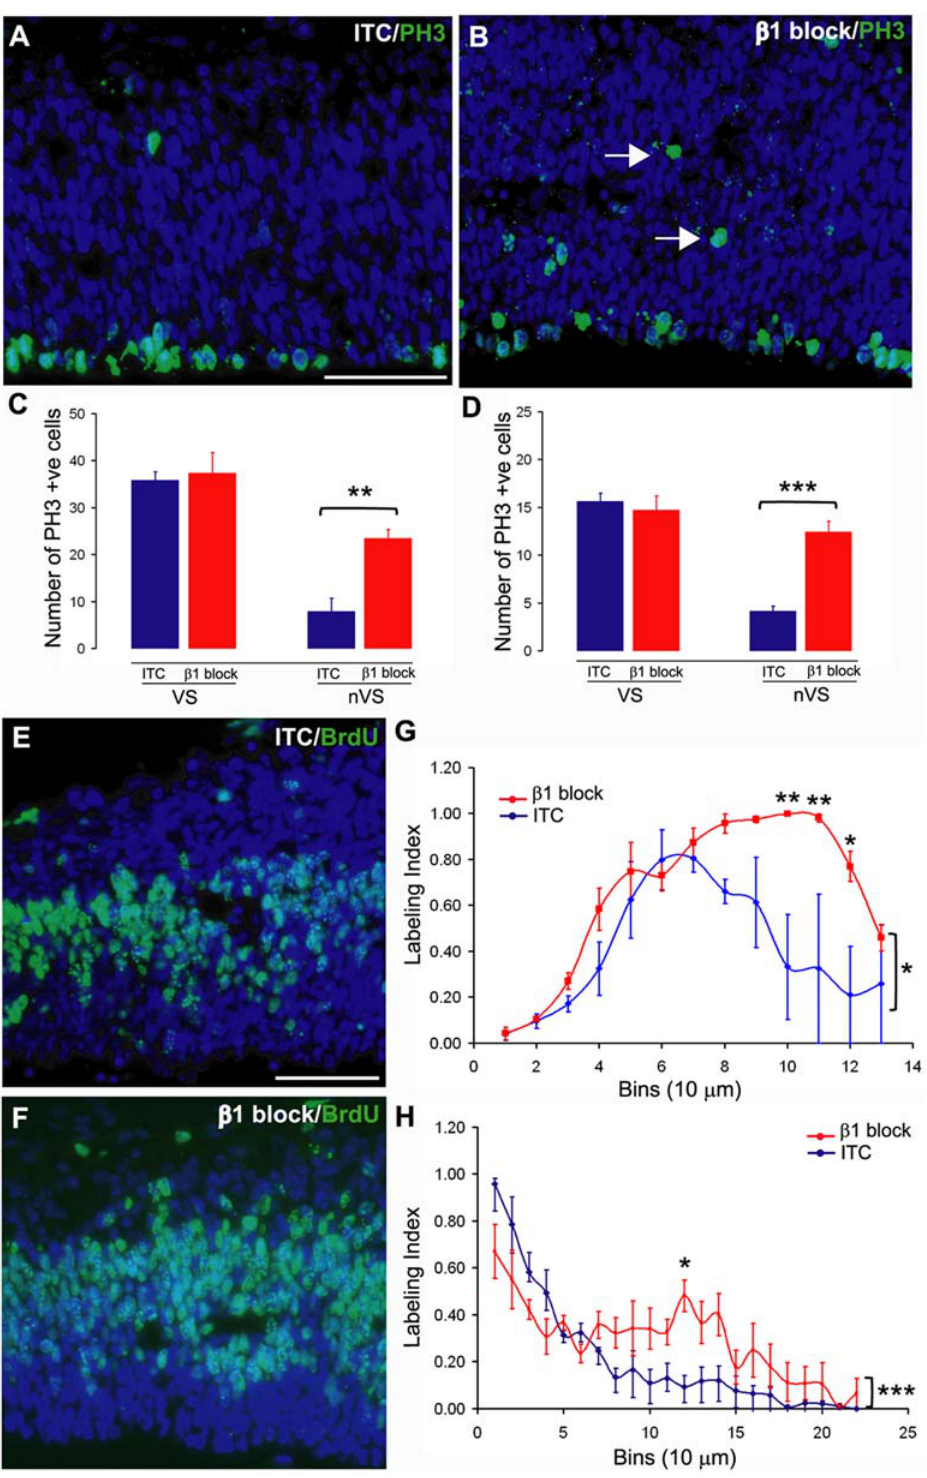
Figure 2. Cell proliferation is disrupted in the embryonic telencephalon after intraventricular injection of a b 1 integrin blocking antibody. (A, B) Fluorescence micrographs of PH3 expression (green, dapi-counterstained nuclei in blue) after antibody injection at E12.5. Note the increase in PH3 + cells away from the ventricular surface in the b 1 integrin blocking antibody-injected embryos (B), white arrows, compared to injected controls (A). (C, D) Quantification of PH3 + cells at the ventricular surface (VS) and nonventricular surface (nVS) after antibody injection at E12.5 (**, p , 0.01 as assessed by a paired two-tailed t -test, C) and E15.5 (***, p , 0.001, unpaired two-tailed t -test, D). (E, F) Fluorescence micrographs of BrdU expression (green, dapi-counterstained nuclei in blue) after antibody injection at E12.5, pulsed 1 h prior to sacrifice. Note the increase in the amount of BrdU + cells in the telencephalon. (G, H) BrdU labelling index in E12.5- (G) and E15.5- (H) injected embryos pulsed with BrdU 1 h (G) or 6 h (H) prior to sacrifice. Note the increase in labelling index at 80–110 m m in the b 1 integrin blocking antibody embryos, **, p , 0.01 for bin 10 and 11, and *, p , 0.05 for bin 12 calculated using Boneferroni post hoc tests. All scale bars represent 50 m m.